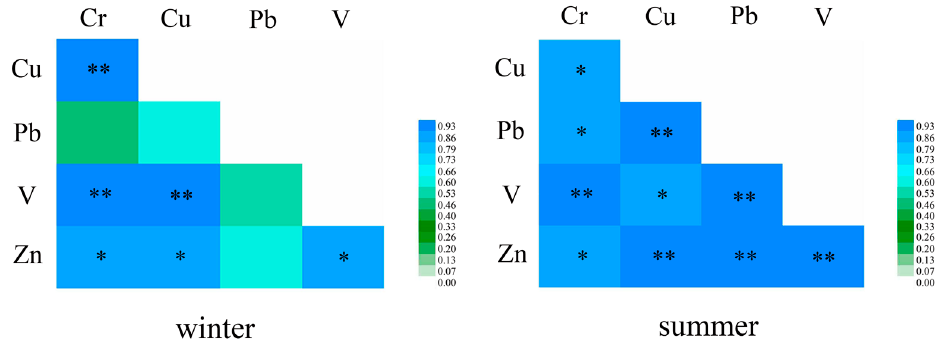
Figure 5. Pearson correlation coefficient matrix between heavy metals in moss bags in winter and summer. * Correlation significant at the 0.05 level; ** Correlation significant at the 0.01 level.